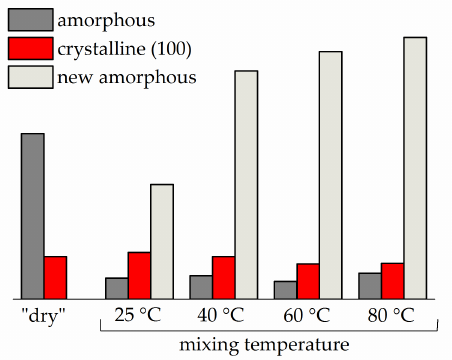
Figure 10. Amorphous and crystalline peak areas for Li-Nafion samples before and after swelling with an EC/SL mixture with ω(SL) = 0.2 at different mixing temperatures (specified in the dia-